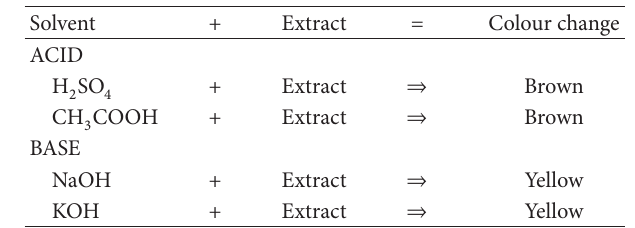
Table 4: Allamanda extracts (cold extract) (initial colour of extract, brown).